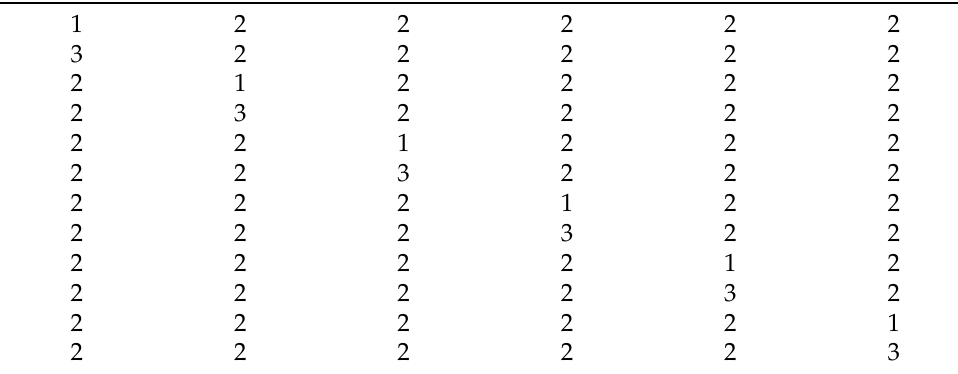
Table A5. F 12 array.